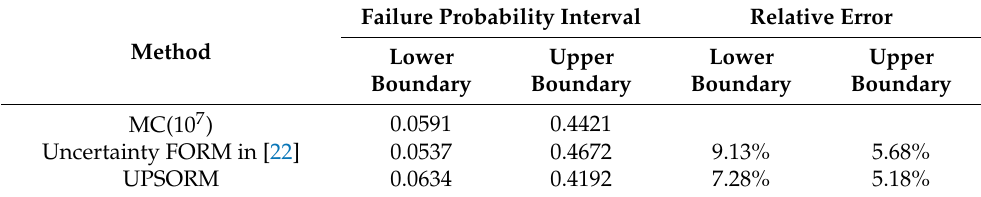
Table 1. Comparison result.